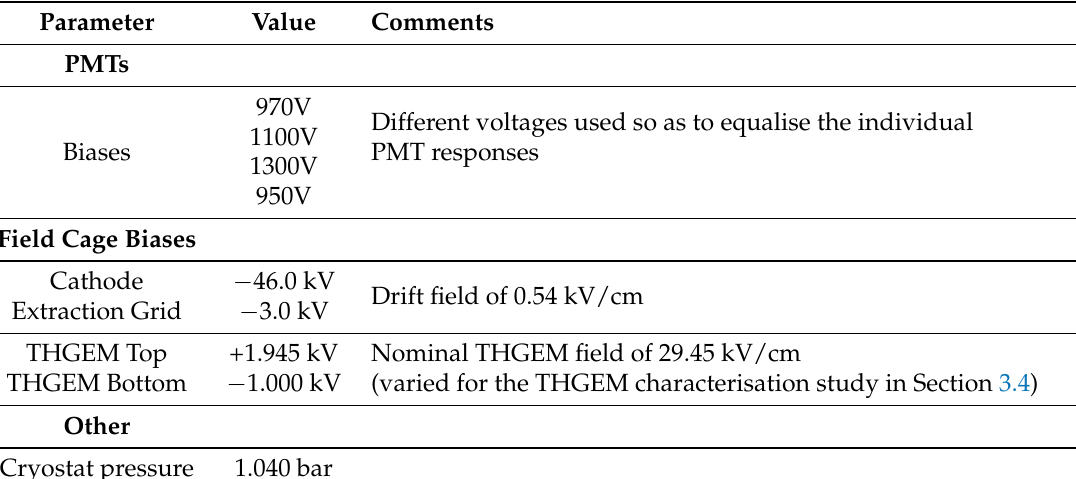
Table 1. Operational parameters for the ARIADNE